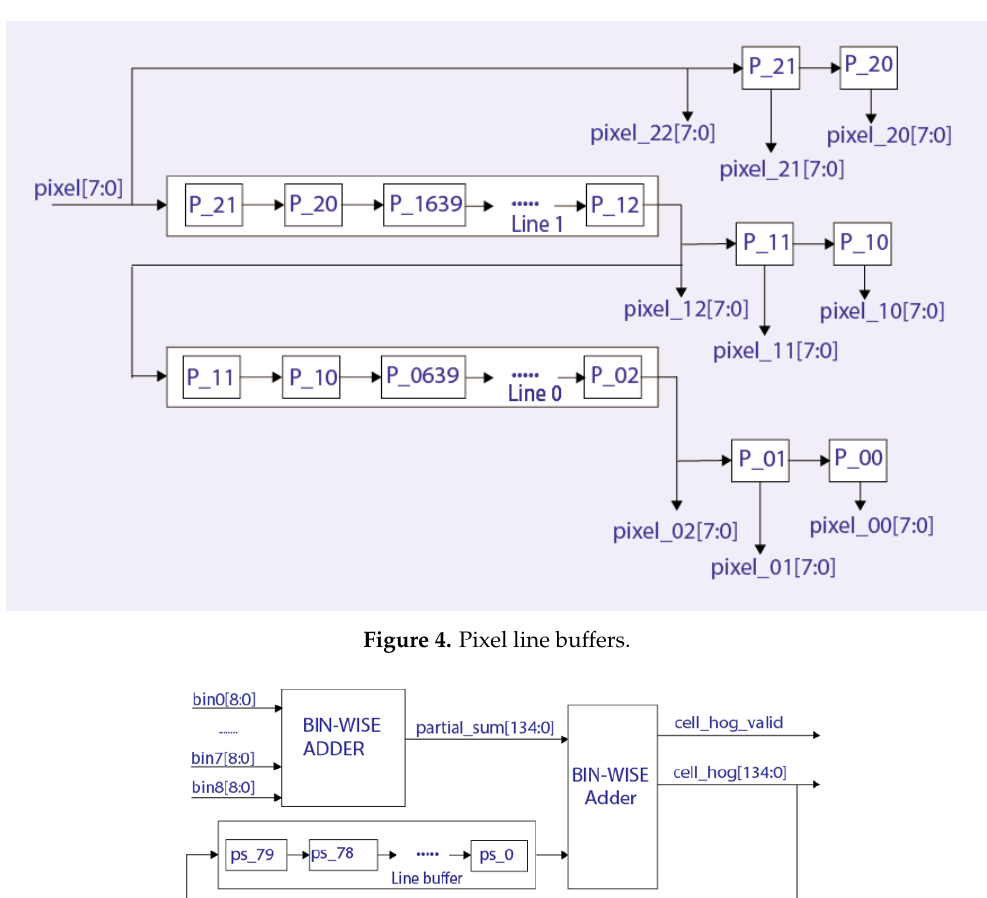
Figure 5. Partial cell hog line